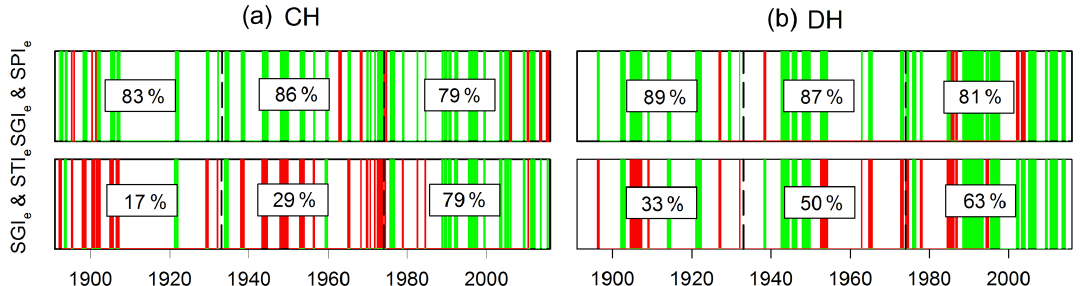
Figure 7. Graphical representation of coincidence of groundwater droughts with precipitation droughts (SGI–SPI) and with hot periods (SGI–STI) for CH (a) and DH (b) , where green denotes coincident and red non-coincident episodes. Percentages indicate the fraction of coincident episodes for the first (1891–1932), middle (1933–1943) and last (1944–2015) thirds of the record (where periods are separated by vertical dashed